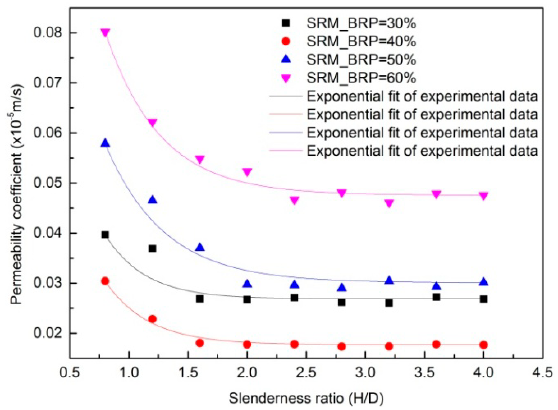
Figure 12. Evolution diagram of the permeability for samples with different slenderness ratio ( H / D ). Water 2017 , 9 , 676 14 of 16 Table 7. Fitting regression functions of permeability coefficient with slenderness ratios ( H / D ). The R 2 is the correlation coefficient.